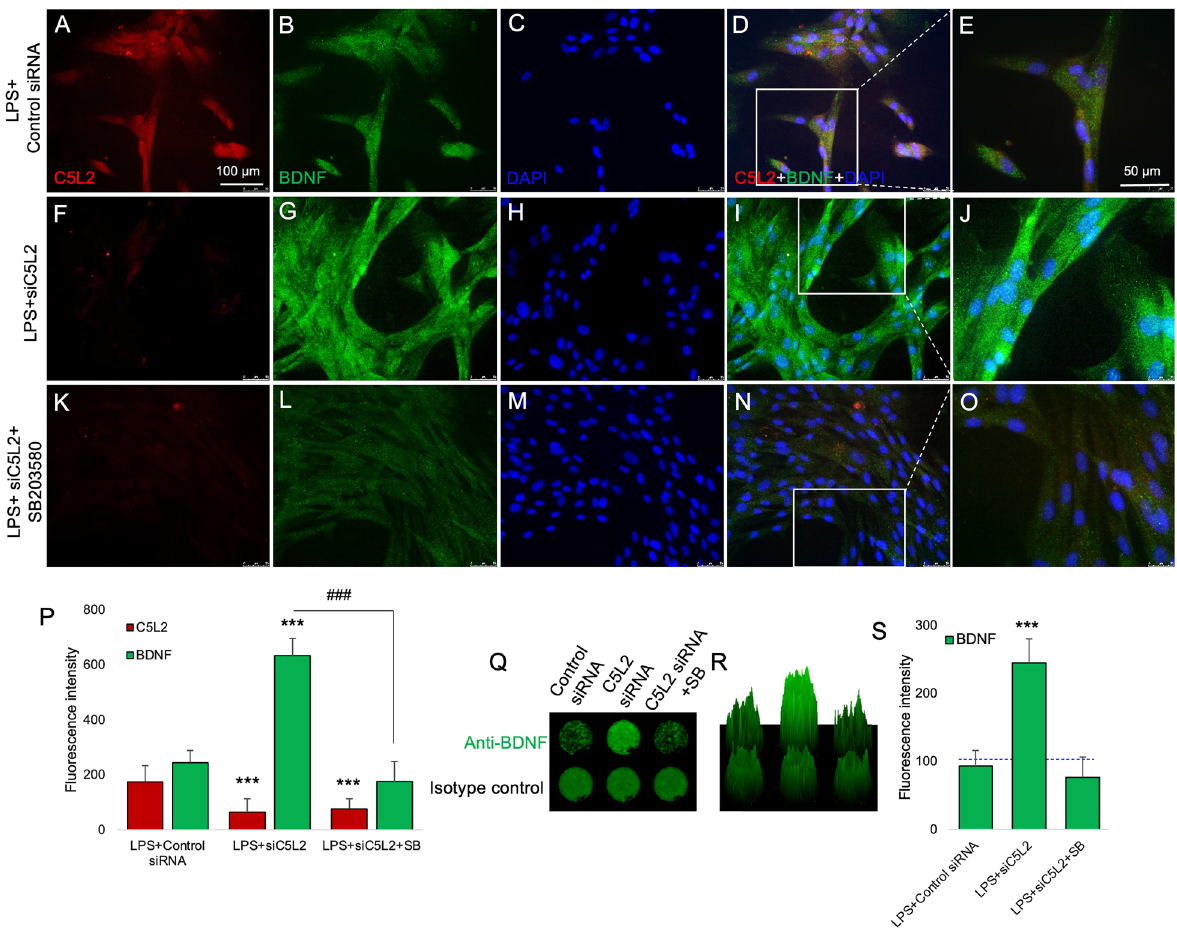
Figure 3. Effect of LPS and p38 MAPK α inhibitor on BDNF secretion in C5L2 silenced DPSCs. ( A-O) Cells were cultured and transfected with control siRNA, or C5L2 siRNA or treated with p38 MAPK α inhibitor (SB203580; SB), stimulated with LPS. Immunofluorescence double staining was used to analyze C5L2 and BDNF expression under LPS stimulation. LPS stimulation enhanced BDNF expression in C5L2 silenced DPSCs under LPS stimulation ( F - J ) compared with control ( A - E ). SB203580 treatment inhibited the BDNF expression in C5L2 silenced DPSCs, indicating p38α involvement in C5L2-mediated BDNF expression ( K – O ). Enlarged figures ( E , J , and O ) show co-localization of C5L2 and BDNF, and C5L2 silenced cells stimulated with LPS ( J ) clearly indicated the increased expression of BDNF. ( P ) The bar graph shows a significant increment in BDNF expression with reduced C5L2 expression while SB203580 treatment obliterated the effects (*** p < 0.001 vs control). ( Q - S ) In-cell western assay further confirmed the immunofluorescence staining results. C5L2 silencing increased the BDNF expression while SB203580 treatment inhibited the BDNF expression in LPS-stimulated C5L2 silenced cells, indicating the role of p38α in C5L2 mediated BDNF expressing DPSCs. 2.5D model ( R ) and the bar graph ( S ) shows a significant increment in BDNF expression compared with control while the effect reversed in SB203580 treated cells (*** p < 0.001 vs LPS potentiate BDNF production in C5L2 silenced DPSCs.